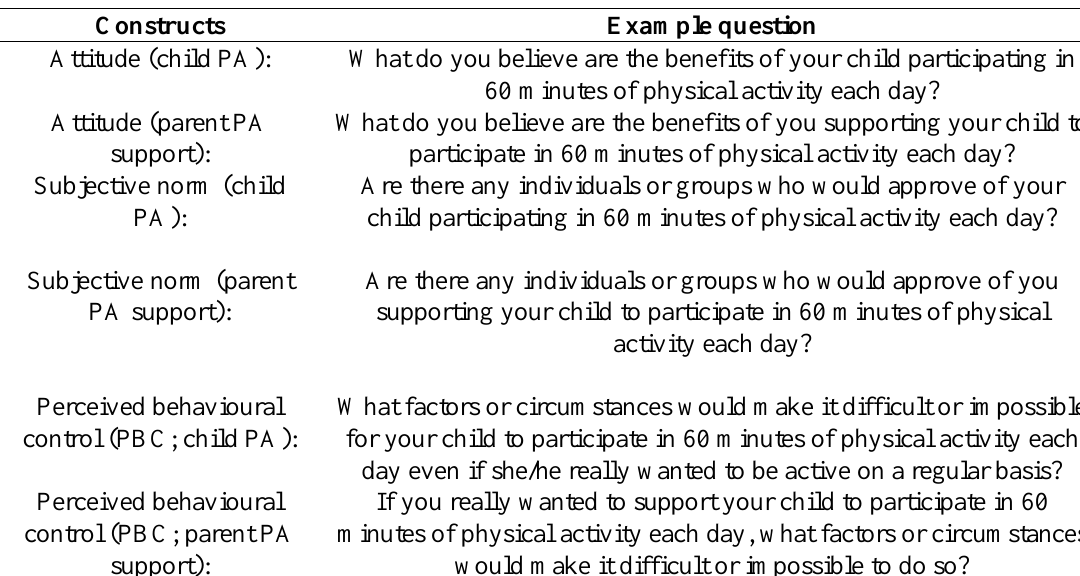
Table 1. Example of Theory of Planned Behaviour elicitation questionnaire